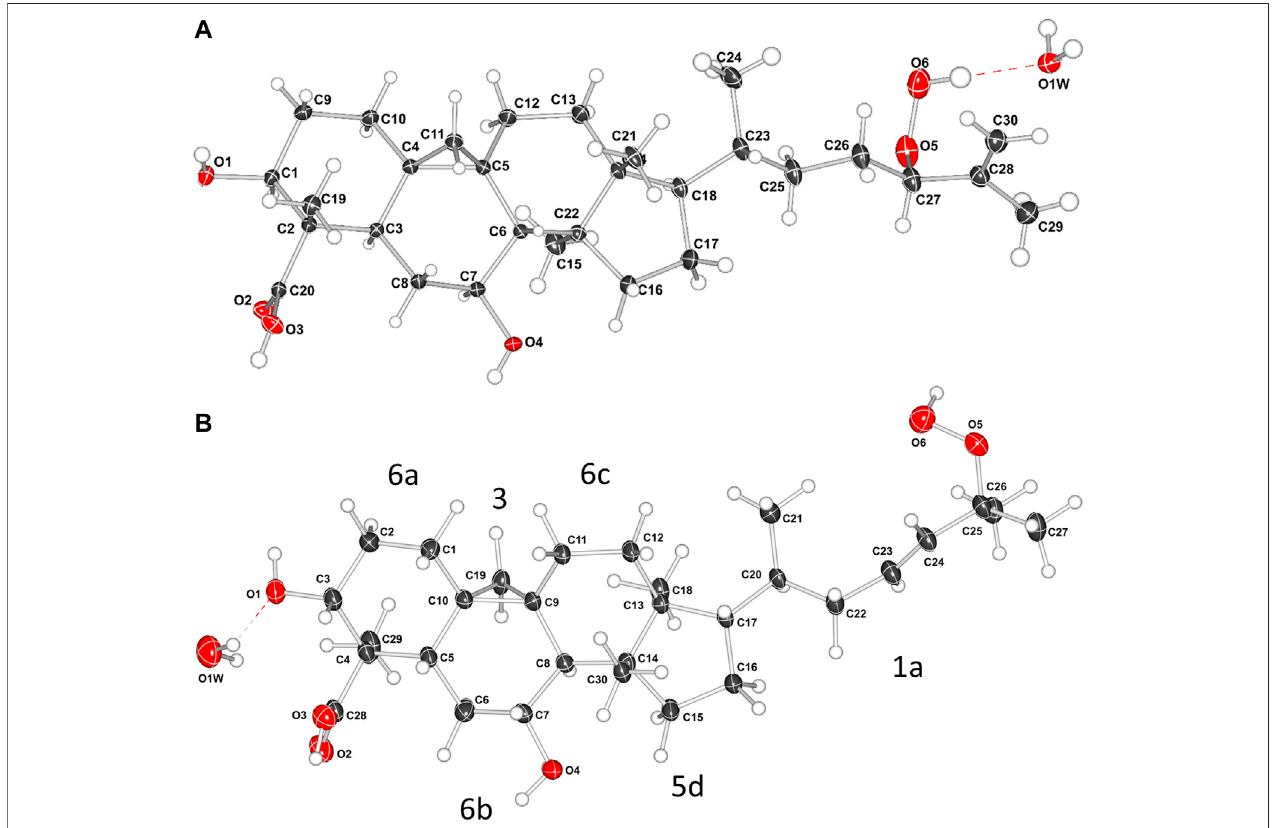
FIGURE 3 | X-ray crystal structures of compound 1 (A) and compound 2a (B) . In B , the labels 6a, 3, 6b, 6c, 5d, and 1a refer to the rings and the alkyl chain; the numbers denote the ring size and the letters denote the position in the molecule.